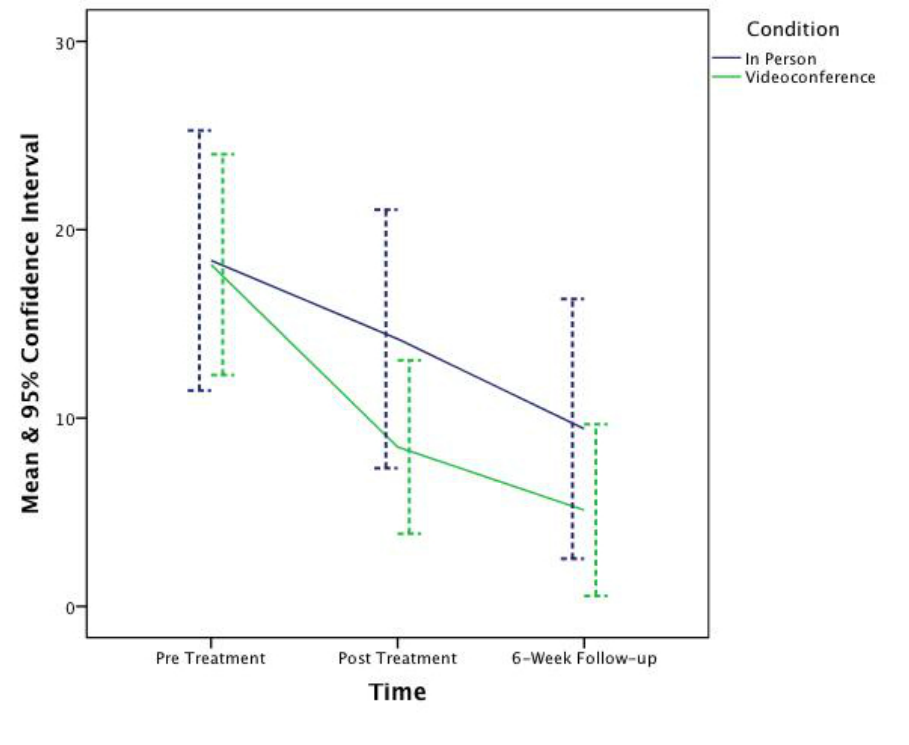
Figure 2. The change in symptoms of depression across time and condition.